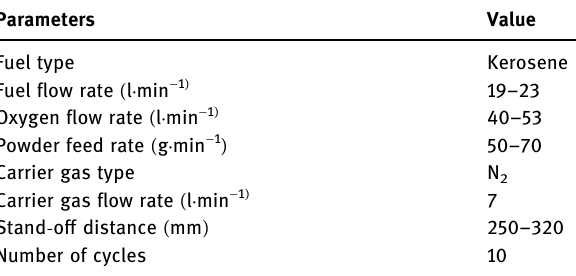
Table 1: HVOF spraying parameters of as - sprayed Cr 3 C 2 – NiCr